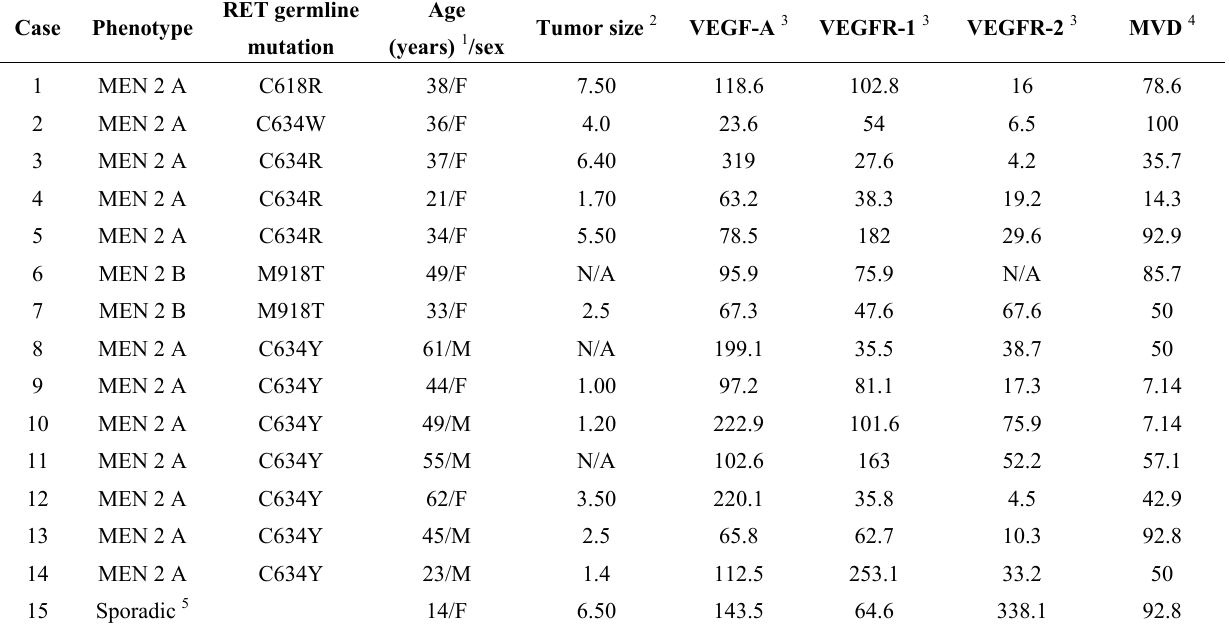
Table 1. Clinical features and vascular endothelial growth factor (VEGF)-A, VEGF